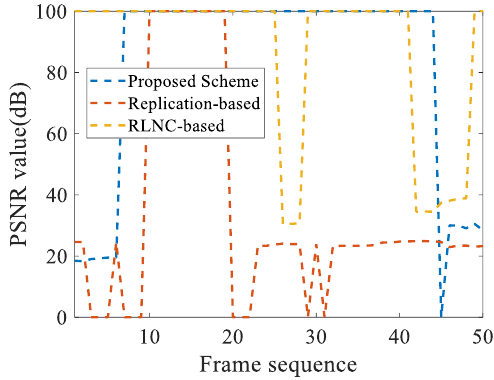
Figure 9. Analysis of video quality.